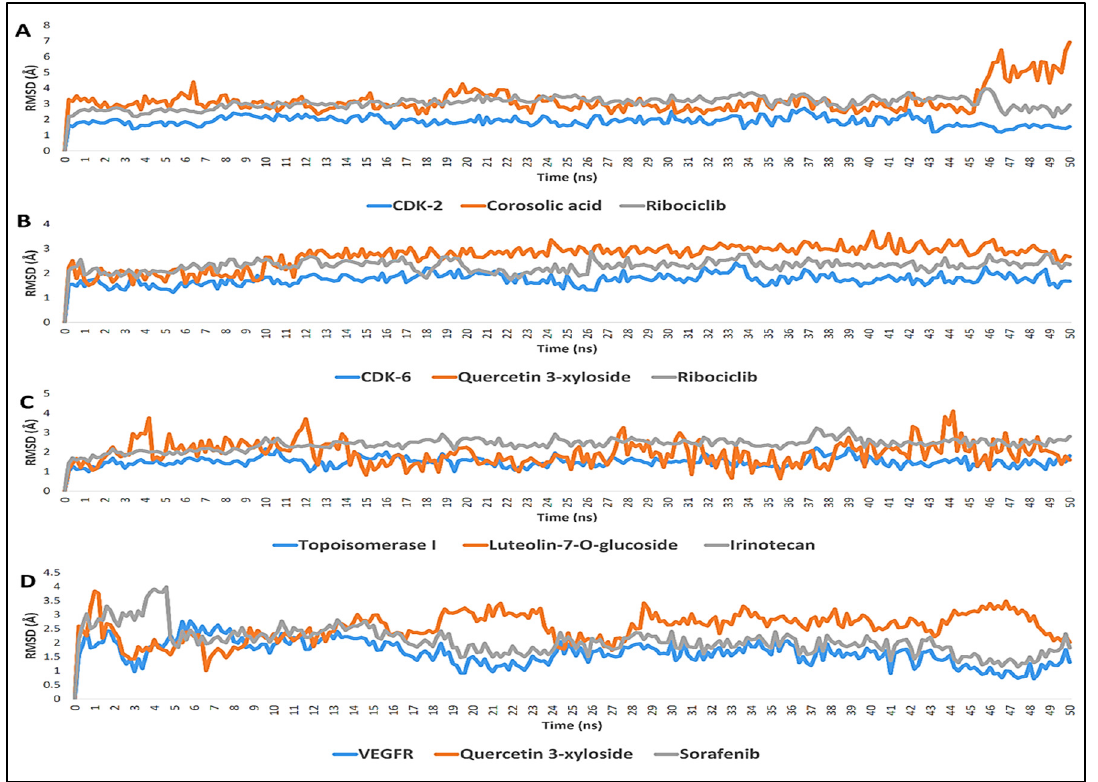
Figure 7. ( A ) The RMSDs of compound 3 inside the binding sites of CDK-2 target over 50 ns of MDS, ( B ) The RMSDs of compound 10 inside the binding sites of CDK-6 target over 50 ns of MDS, ( C ) The RMSDs of compound 16 inside the binding sites of topoisomerase-1 target over 50 ns of MDS, and ( D ) The RMSDs of compound 10 inside the binding sites of VEGFR-2 target over 50 ns of MDS.